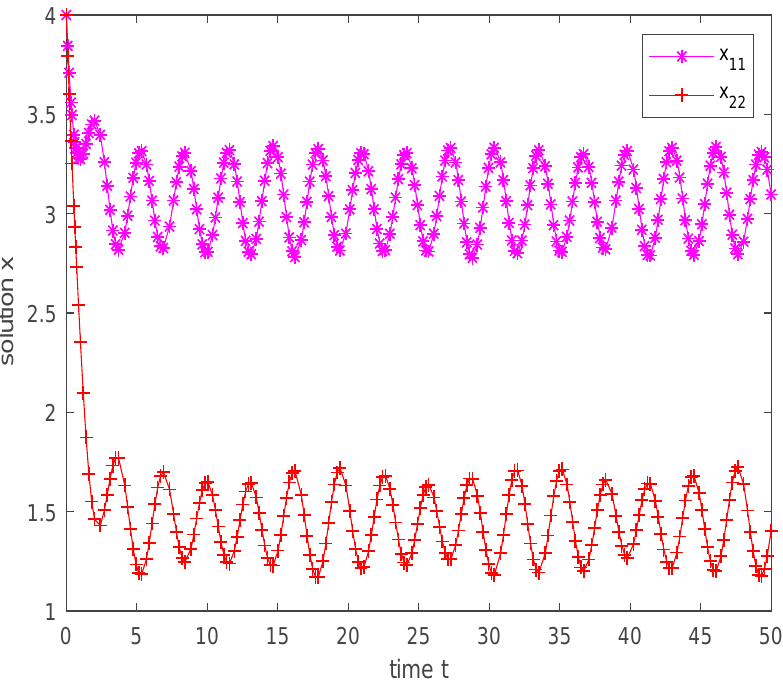
Figure 4. The state trajectory of x 11 and x 22 , and initial values are x 11 ( 0 ) = x 22 ( 0 ) = 4.0.